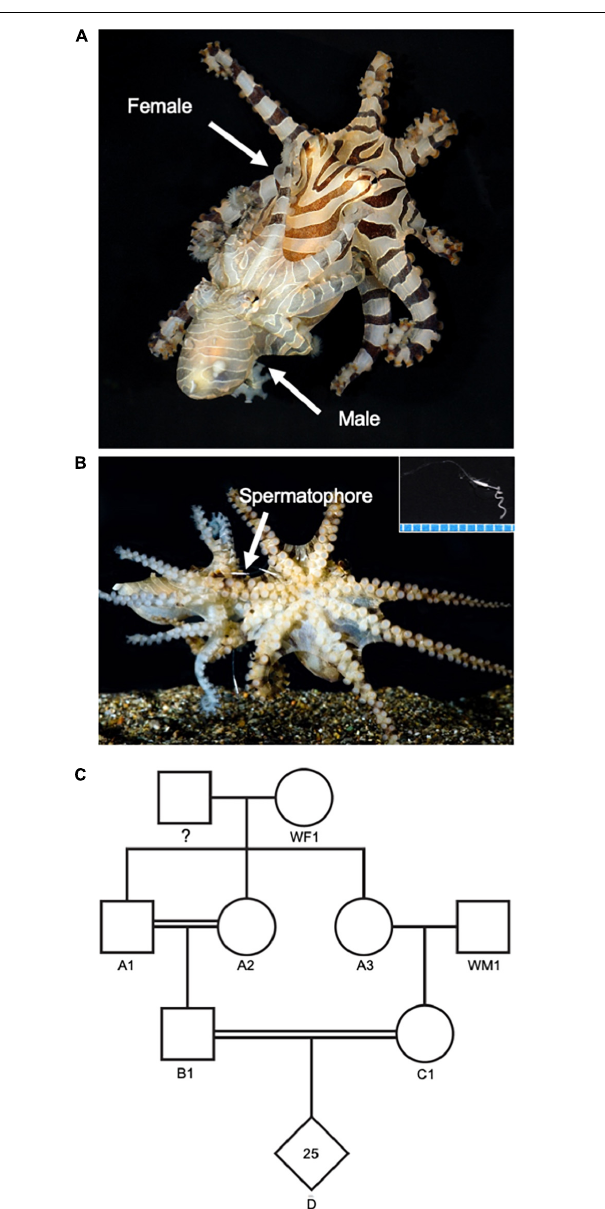
FIGURE 5 | Octopus chierchiae m ating and reproduction. (A) Male (smaller octopus with pale coloration) and female (larger octopus with dark banded coloration) mating (dorsolateral view). The male inserts the tip of his third right arm, called the hectocotylus, into the female’s mantle opening to deliver spermatophores. (B) Visible spermatophores during mating. Inset depicts a spermatophore (scale: millimeters). (C) Pedigree showing parental lineage of a third-generation clutch. Squares represent males, circles represent females, diamonds represent clutches, double solid lines highlight inbred pairs. Female WF1 was a wild-collected female. Prior to capture, she had mated unknown male(s) and produced Clutch A upon arrival in the lab. Two offspring from Clutch A (A1 and A2) were bred together and another offspring from Clutch A (A3) was outbred with a wild-collected male (WM1) to produce two second generation clutches. Two individuals from these second-generation clutches (B1 and C1) mated to produce a third-generation clutch (D) with 25 hatchlings. Note: for clarity, non-reproductive offspring of the first- and second-generation clutches are not represented in this